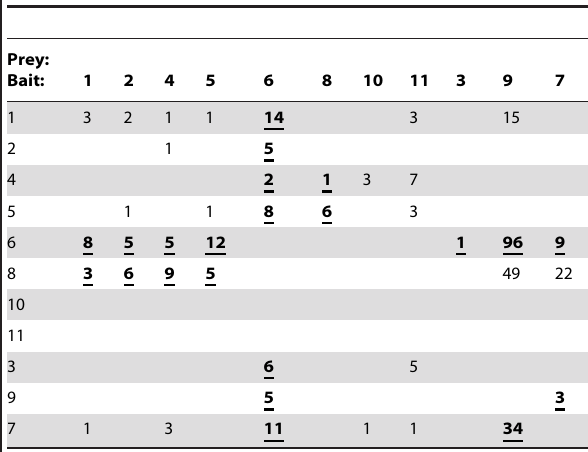
Table 1. Correlation of septin prey clones (columns) fished by a given bait septin